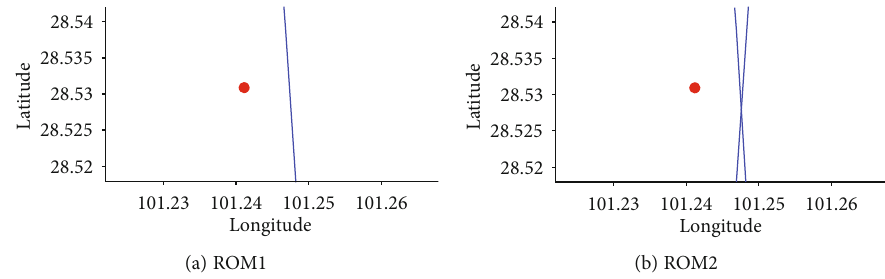
Figure 13: Enlarged views of the ground tracks of the ROM1 and the